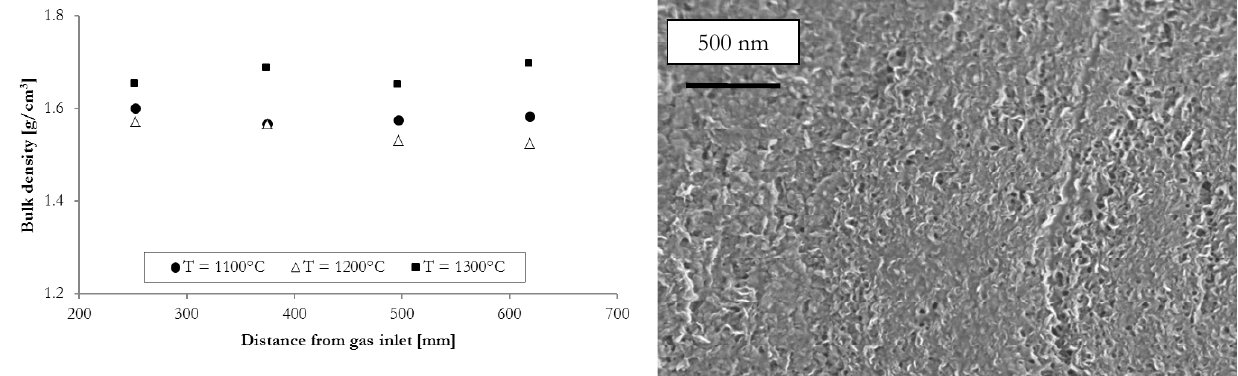
Figure 6: C f /C bulk density. Figure 7: SEM micrographs of